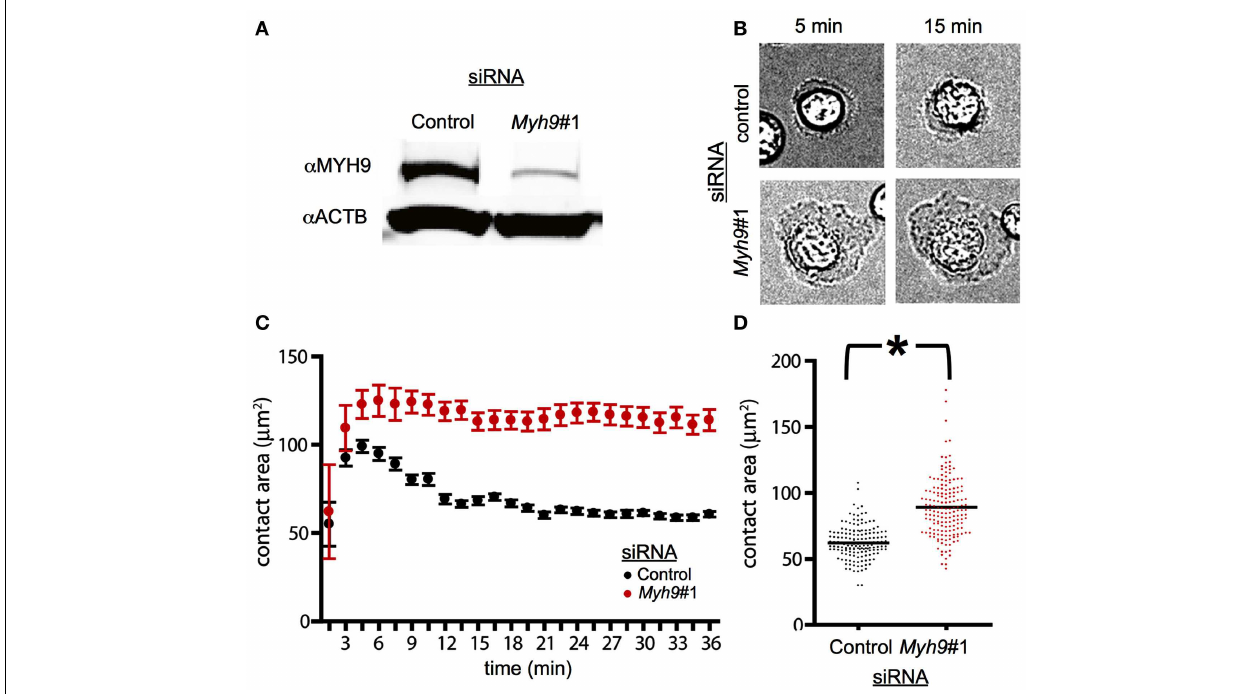
cells treated with control siRNA (black) and Myh9 #1 siRNA (red) determined using IRM images at the indicated time points. Each point shows mean and standard deviation in a single field followed over 36min. While the control cells display a distinct contraction, this is absent in Myh9 #1 siRNA-treated cells. (D) Scatter plot of contact area for control (black) or Myh9 #1 siRNA-treated cells for several fields at 30min. * p < 0.0001.This increased contact area in Myh9 #1 siRNA-treatedT cells has been observed in 6 of 6